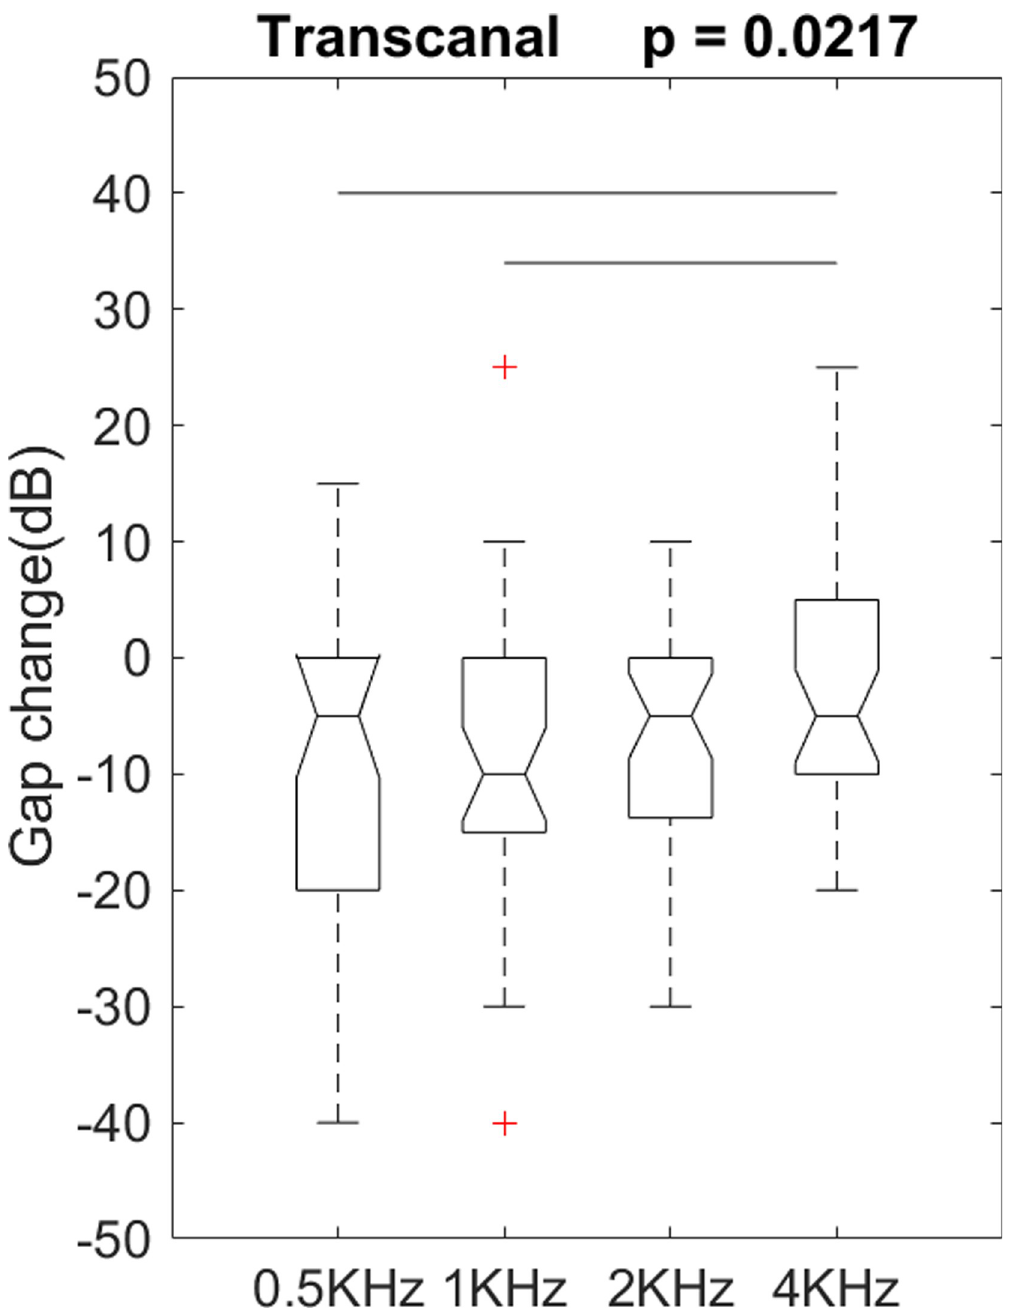
Fig 4. A one-way analysis of variance showed significantly different postoperative gap change among the frequencies in the transcanal group. +: An outlier. Each boxplot displays a five-number summary: The minimum, the maximum, the median, and the first and third quartiles. A horizontal line indicates a significant difference between the 2 frequencies in the post hoc comparisons. There were 3 and 1 unsuccessful repair drums observed 3 months after the postauricular and transcanal surgeries, respectively. The successful repair rate was 91.4% and 97.1% after postauricular and transcanal tympanoplasties, respectively. A chi-square test showed the suc- cessful repair rate did not differ between the 2 groups, X 2 (1, N = 70) = 0.2652, p = 0.6066.